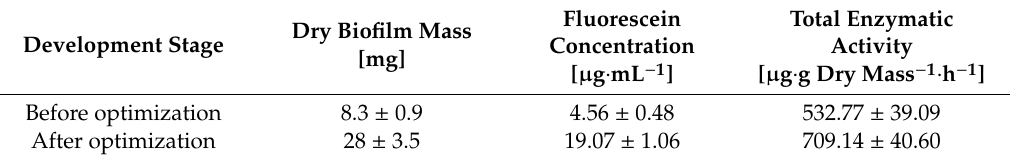
Table 1. Comparison of the B. thuringiensis B1(2015b) biofilm mass that was created on loofah sponge and its metabolic activity before and after the optimization of the immobilization